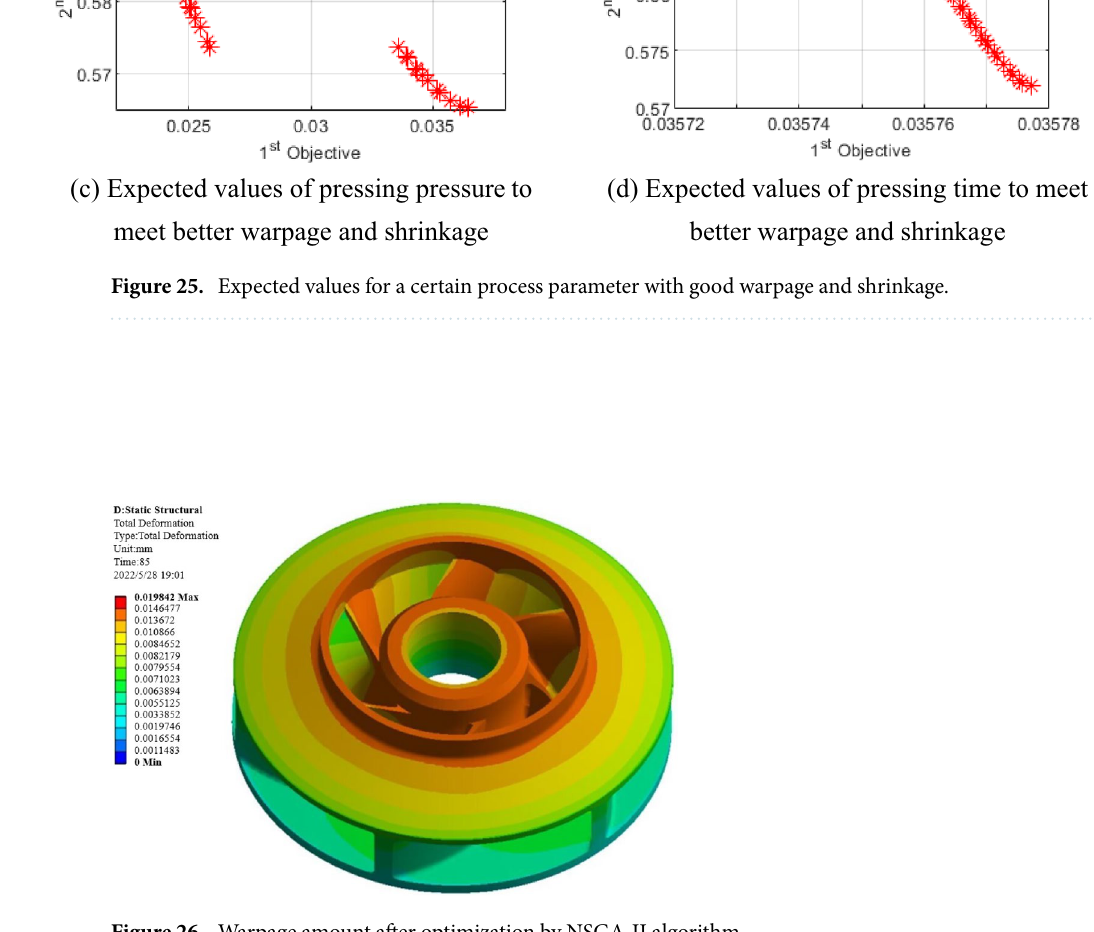
Figure 26. Warpage amount after optimization by NSGA-II